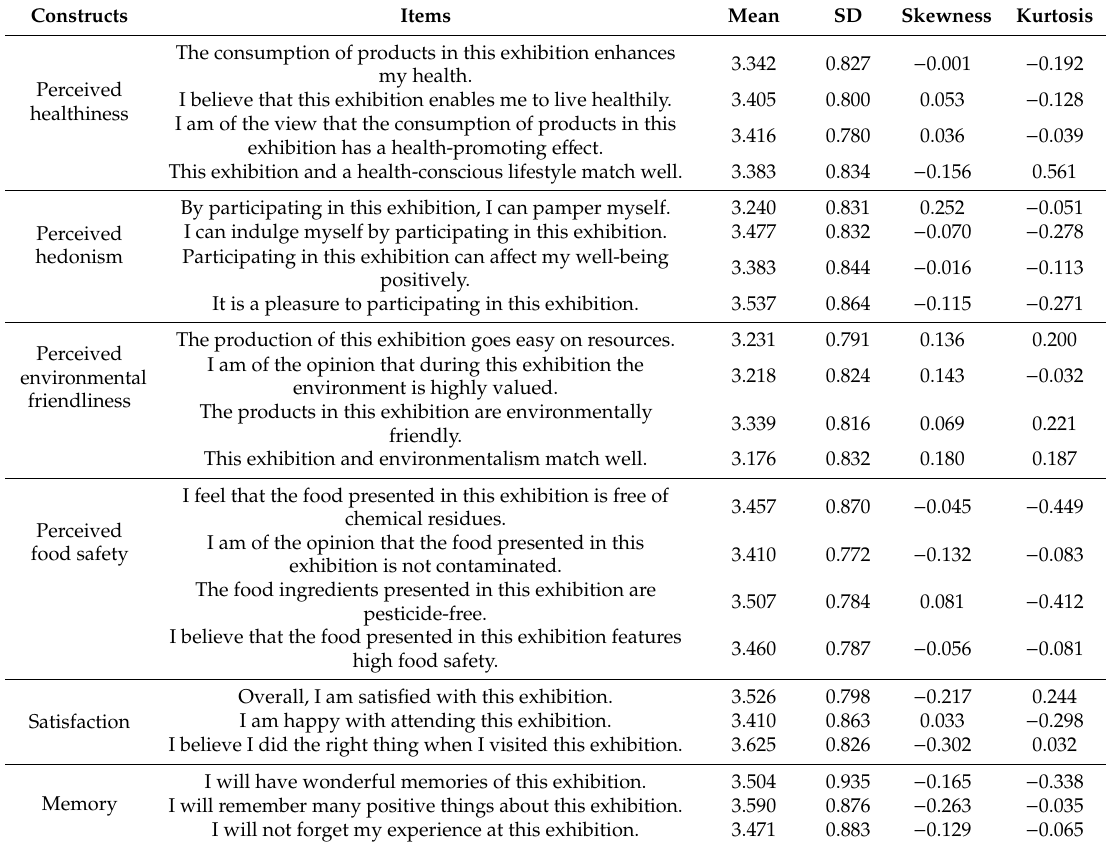
Table A1. Normal distribution